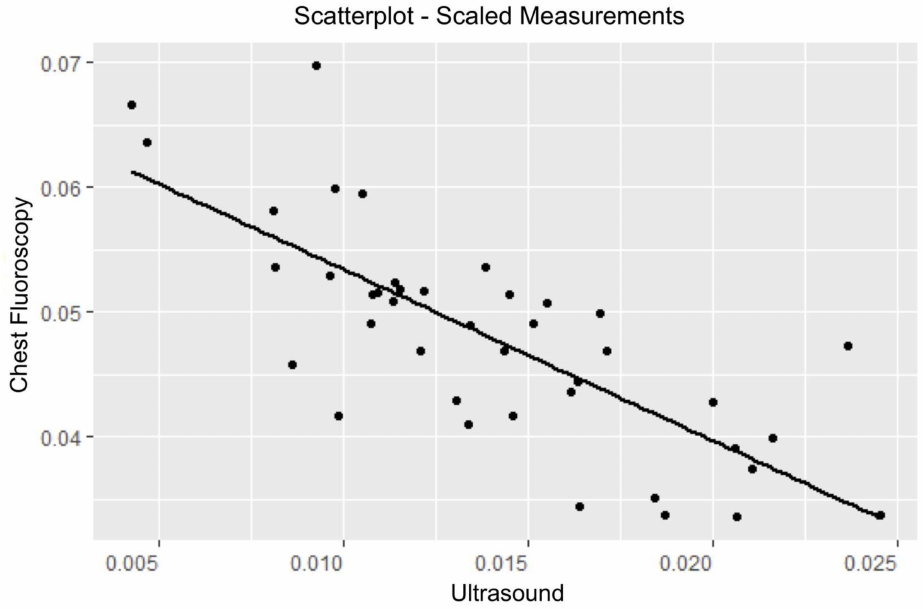
Figure 2. Scatter plot of scaled chest fluoroscopy vs. scaled ultrasound